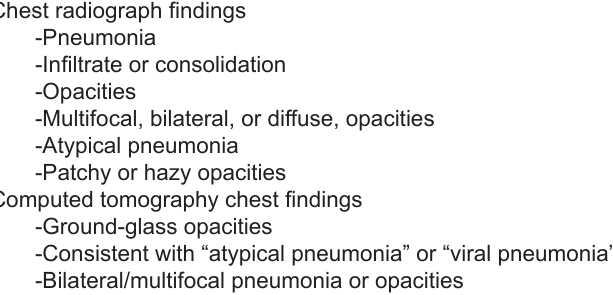
Figure 1. Radiology findings suggestive of SARS-CoV-2 infection.